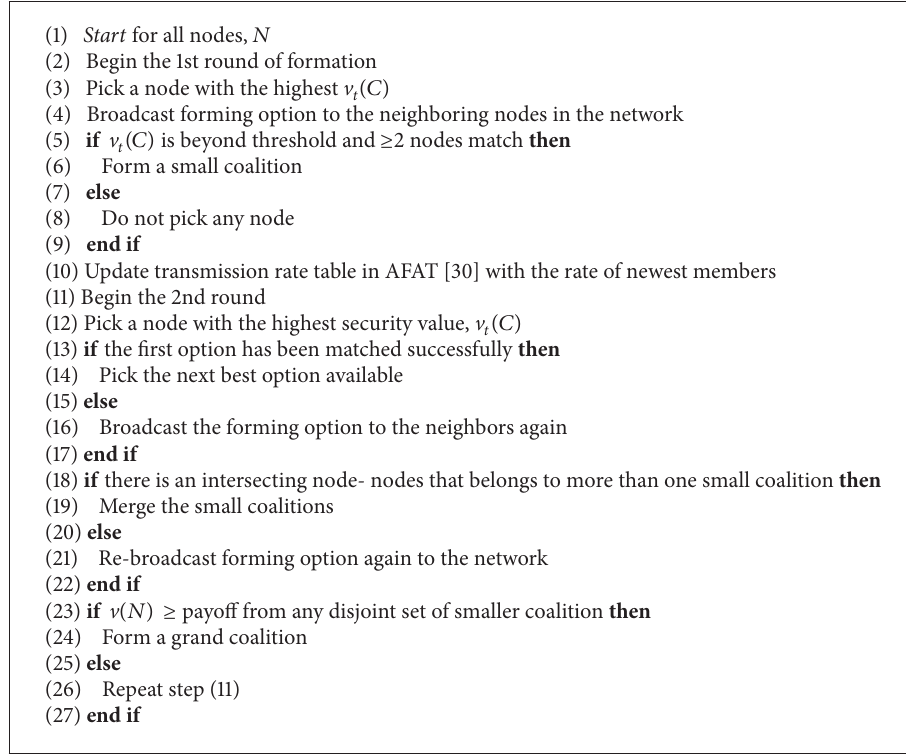
Algorithm 1: Algorithm for coalition